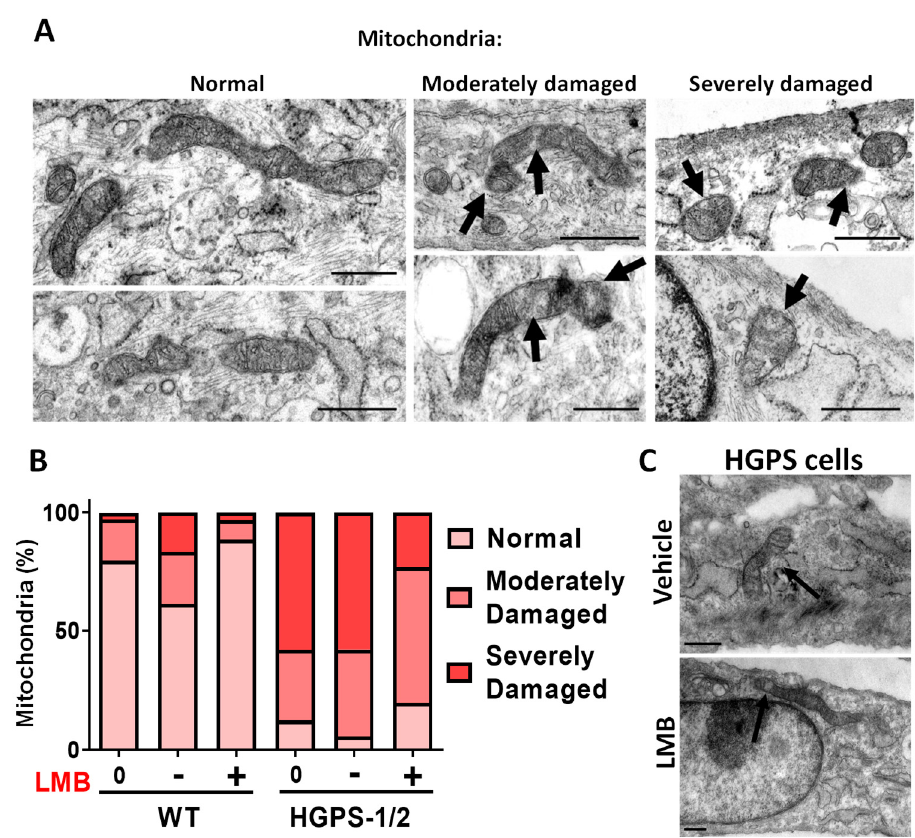
Figure 2. Electronic microscopy (EM) analysis of mitochondria in WT and HGPS cells subjected to LMB treatment. Primary fibroblast cell cultures were incubated for 3 days with LMB or the vehicle alone as in Figure 1, before EM imaging. ( A ) Typical transmission electron micrographs are shown (scale bar, 500 nm). Mitochondria were evaluated for the integrity of the membrane, matrix and cristae, and were classified as mitochondria with normal morphology; moderately damaged mitochondria (moderate alterations in the membrane, and the presence of inclusions in the matrix); and severely damaged mitochondria (severe alterations in the membrane shape with increased mitochondrial volume [swollen], and alteration of the cristae with internal aggregates). Arrows point to the aberrant mitochondrial structures. ( B ) The percentage of mitochondria with each morphological pattern found in WT and HGPS 1–2 cell cultures treated with LMB (+) or the vehicle alone ( − ), as well as untreated cells (0), is shown (n > 100 mitochondria per experimental condition). ( C ) Typical EM images of HGPS cells treated with LMB or the vehicle alone are shown (scale bar, 500 nm). Arrows point to the aberrant (vehicle-treated HGPS cells) or restored (LMB-treated HGPS cells) mitochondrial structures.